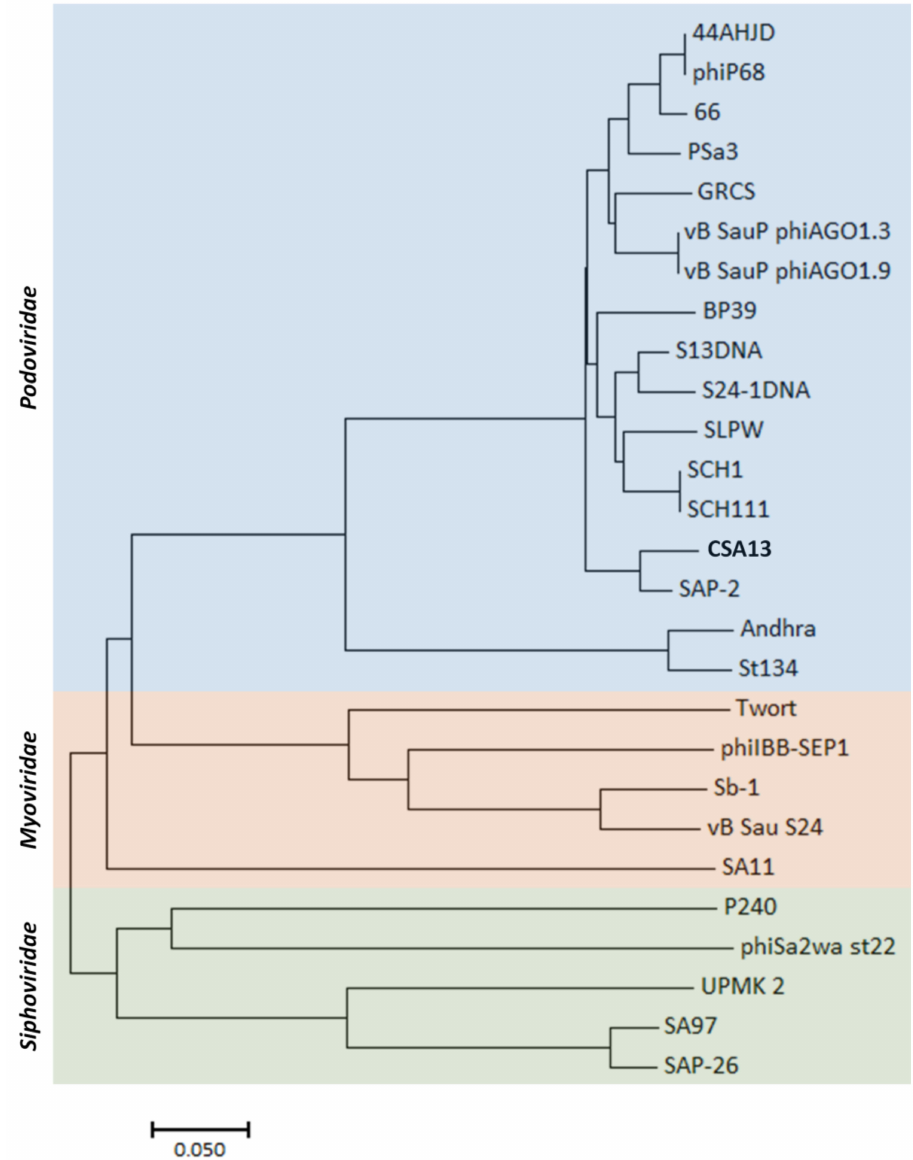
Figure 5. Phylogenetic tree of staphylococcal phages. Whole-genome sequences were aligned using ClustalW. The tree was constructed with neighbor-joining method, and the evolutionary distances were computed with the p-distance method by MEGA7